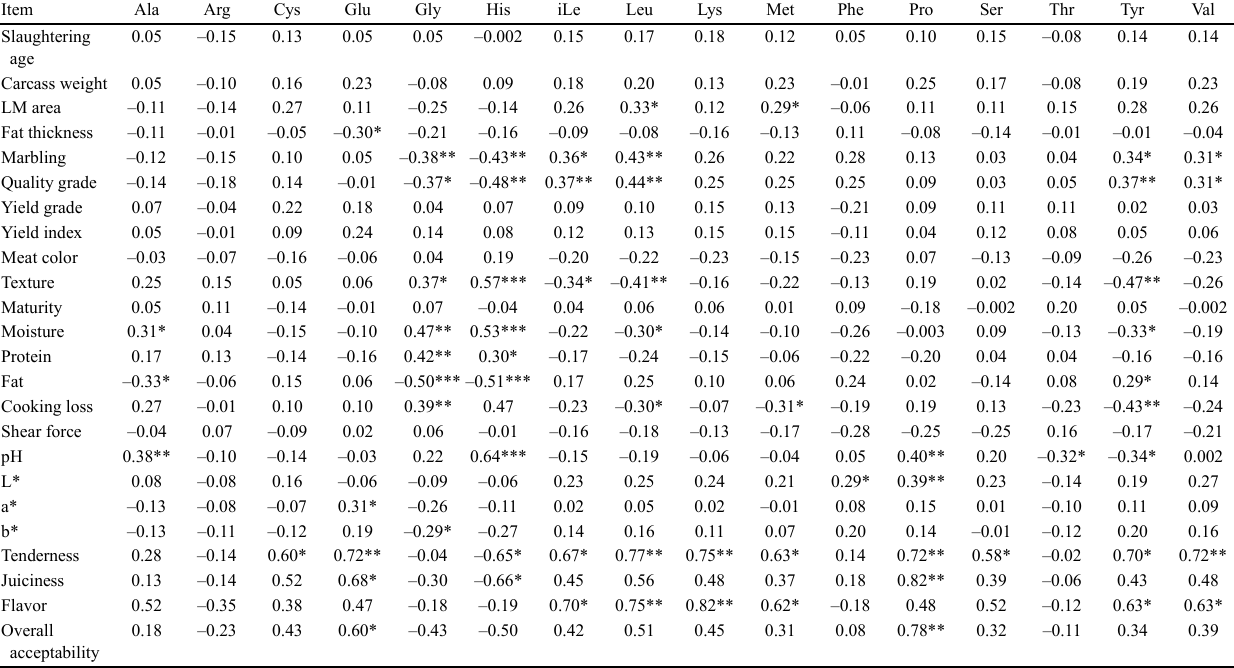
Table 12. Pearson correlation coefficient between carcass traits and chemical composition, and sensory characteristics and amino acid contents of loin in Korean cattle steers Item Ala Arg Cys Glu Gly His iLe Leu Lys Met Phe Pro Ser Thr Tyr Val Slaughtering 0.05 age Carcass weight